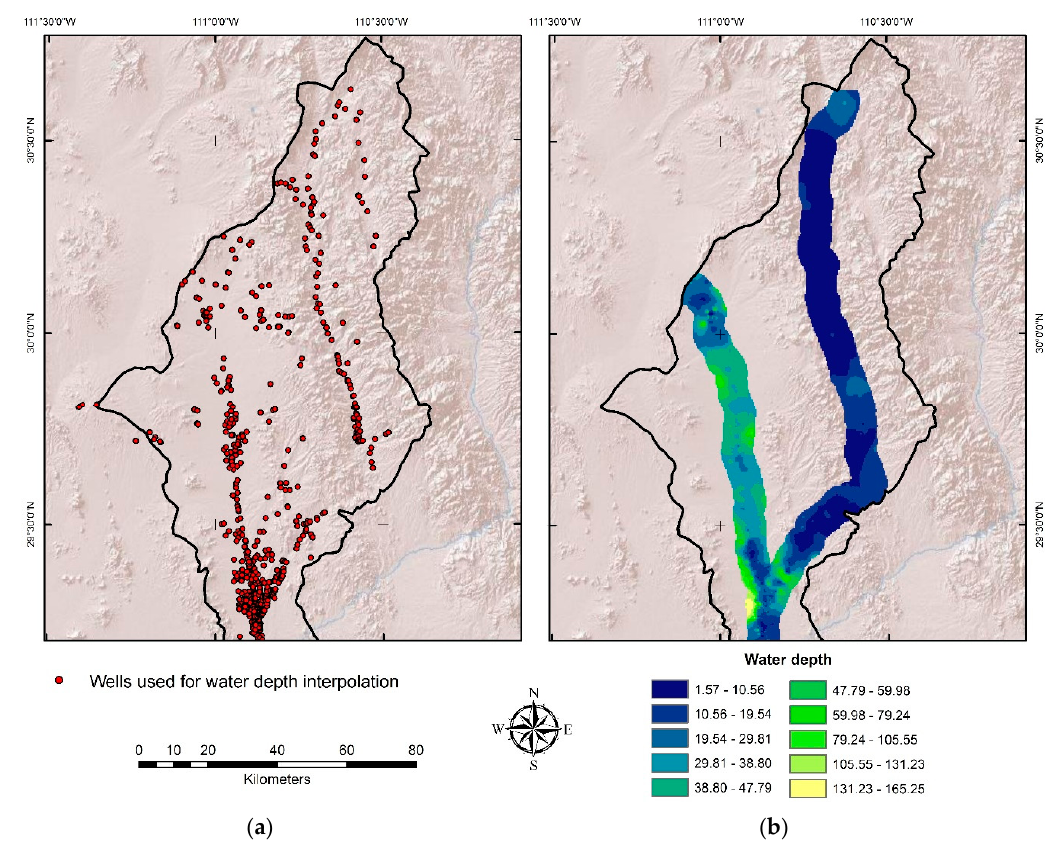
Figure 5. Well distribution from where water depth readings were collected ( a ) and 5 km buffer extraction; ( b ) of water depth surface (generated after IDW interpolation) along rivers.